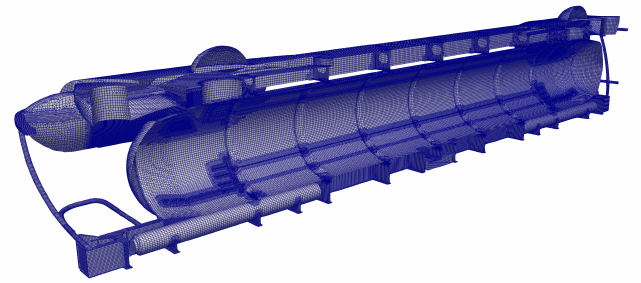
Figure 7. Geometry 3: Sliced view of the discretised surface geometry of the